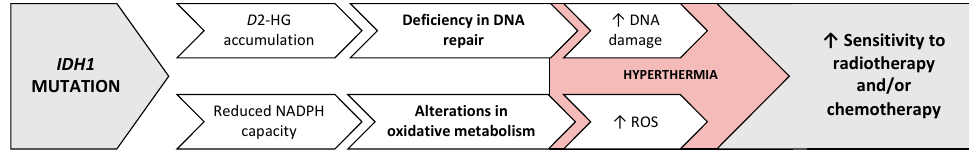
Figure 7. Effect of hyperthermia and PARPi in IDH1 MUT cancer cells. Hyperthermia-induced sensitivity of IDH1 MUT cancer cells is likely mediated by at least two components causing cell death: first, the reduced effectiveness of DNA repair systems, and second the relatively low redox status of IDH1 MUT cancer cells. A dysfunctional homologues recombination repair system and altered oxidative stress responses due to the altered metabolism explain the susceptibility of IDH1 MUT cancer cells to the combinational treatment with hyperthermia and/or PARPi.